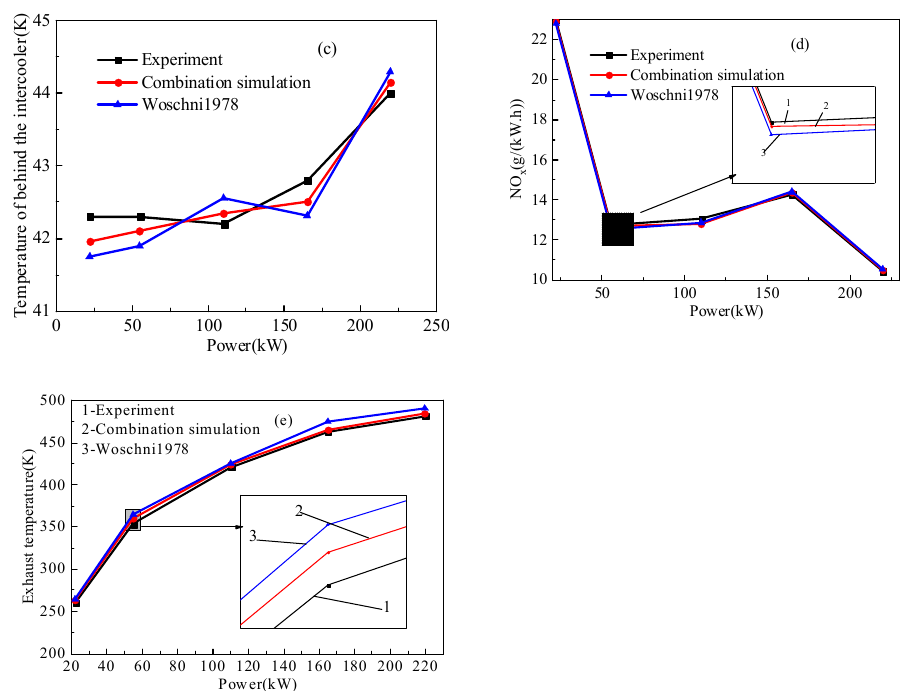
Figure 4. Load characteristics of an electronically-controlled diesel engine. ( a ) Torque; ( b ) BSFC; ( c ) Temperature of behind the inter-cooler; ( d ) NO x ; ( e ) Exhaust temperature